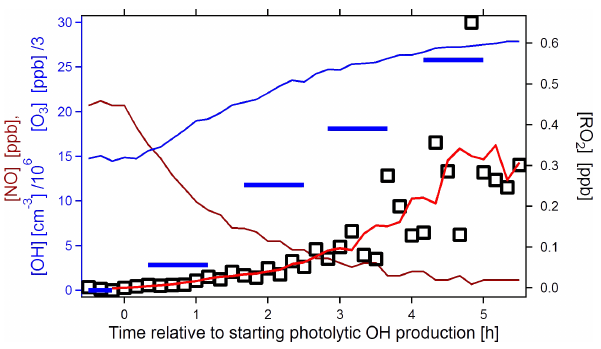
i h ) using deviation from PSS RO 2 i Fig. 9. Estimated (cid:2) RO 2 (cid:3) ( = P i and an average rate constant k 2 = 9 × 10 − 12 cm 3 s − 1 for Reac- tion (R2). The open black squares show the original calculation, the red line shows the five point moving average of the [RO 2 ] data (both right-hand y scales). The brown line shows the NO concen- trations measured during the experiment, the blue bars indicate OH concentrations divided by 10 6 for clarity, and the blue line shows the ozone concentrations divided by 3 for clarity (left-hand y scale). New particle formation started 5h after the TUV lamp was switched on. Then [NO] had decreased to ∼ 1ppb and [RO 2 ] had increased to ∼ 300ppt. Errors in [NO x ] ( ± 8%), [O 3 ] ( ± 2ppb), and [OH] ( ± 10%), are estimated as before but not shown for clarity. Errors in absolute values of [RO 2 ] are not shown because they are unknown. These errors depend on the error of the average rate constant for the mix, which is